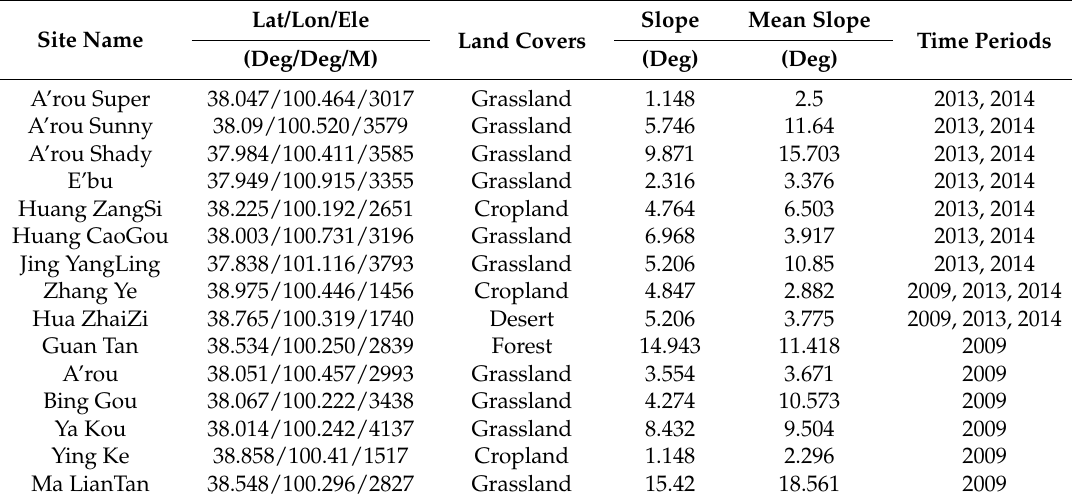
Figure 4. Study area: ( A ) the overview of the study area; ( B ) the location of the Automatic Weather Stations (AWSs) in the DEM imageries; and ( C ) one example of the AWSs. Table 3. The description of the selected AWSs.